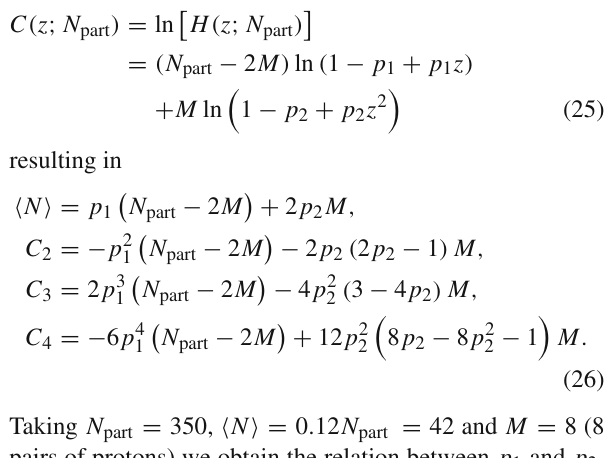
Fig. 4 Integrated multi-particle correlations C n in the model where particles are correlated in pairs ( left ) and quartets ( right ) as a function of the probability for a pair ( p 2 ) or a quartet ( p 4 ) to end up in the rapid-